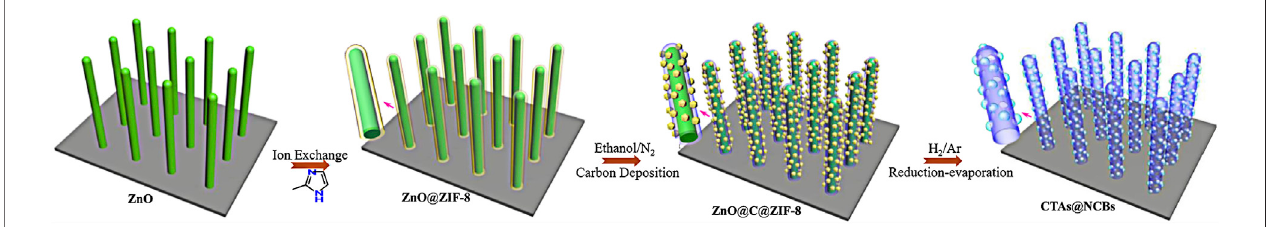
FIGURE8| TheformationprocessofMOF-derivedN-dopedcarbonnanomaterials(includingitsprecursors,treatmentconditionsandtheintroductionofnitrogen), whichshownoutstandingrateperformanceandcyclingstability.SuchillustrationwouldprovidereaderaclearguidelineonhowtodesignMOF-derivedcarbonsashigh- performance supercapacitor electrode materials.